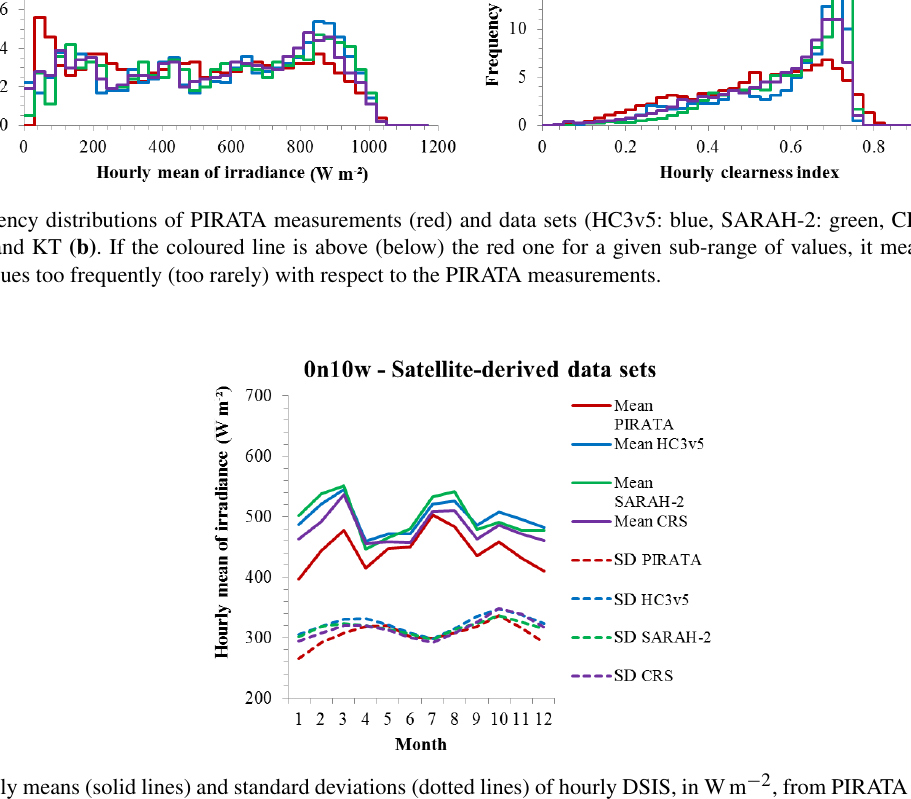
Figure B3. Monthly means (solid lines) and standard deviations (dotted lines) of hourly DSIS, in Wm − 2 , from PIRATA measurements (red) and data sets (HC3v5: blue, SARAH-2: green, CRS: purple) at 0 ◦ N, 10 ◦ W. A difference between red line (measurements) and coloured line (data set) for a given month denotes a systematic error for this month: underestimation if the coloured line is below the red line, overestimation otherwise. For a given month, a coloured dotted line above the red one means that the data set produces too much variability for this month; in the opposite case, the data set does not contain enough